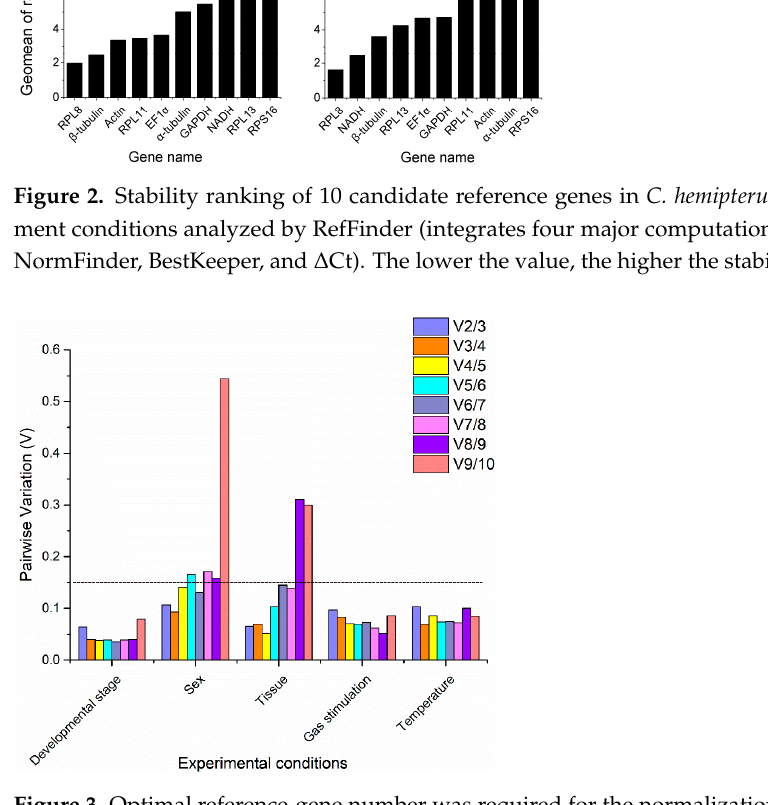
Figure 3. Optimal reference-gene number was required for the normalization of target-gene expression in C. hemipterus under the different experimental conditions. The pairwise variation (V) value was calculated using geNorm to evaluate the optimal reference-gene number in the qRT-PCR analysis. A value less than 0.15 indicates that n reference genes are sufficient to normalize the expression of the target gene.